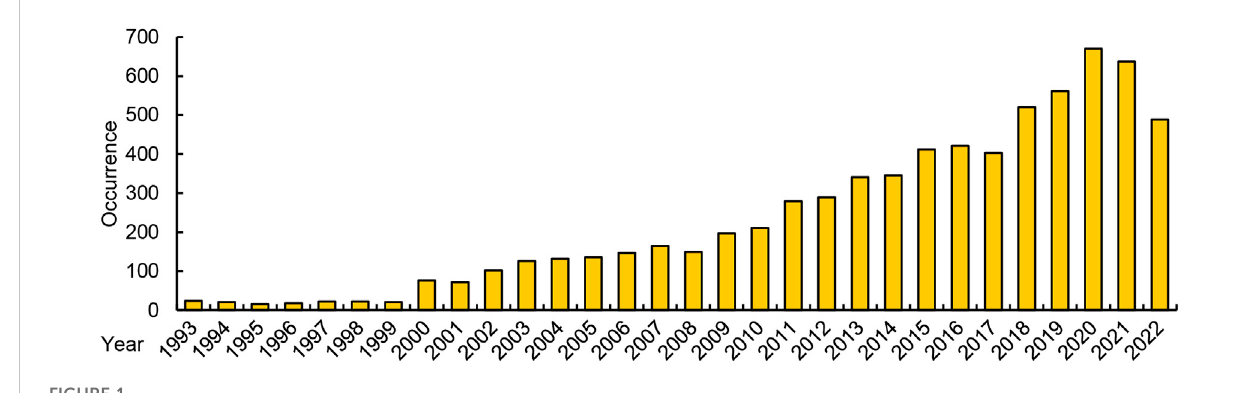
FIGURE 1 The number of algae - PUFA -related research reports in recent years in the web of